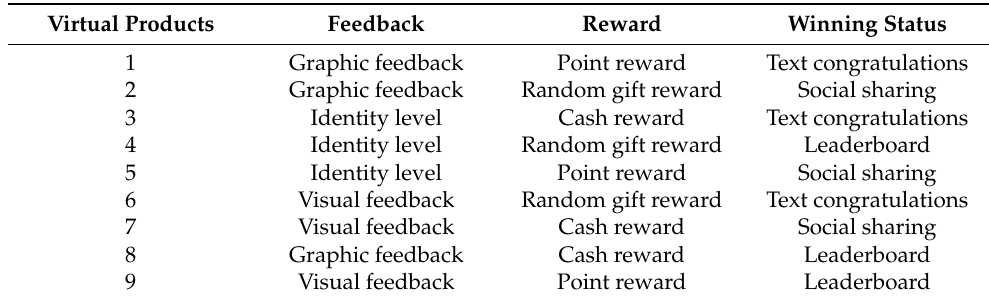
Table 4. Designing nine virtual product prototypes.